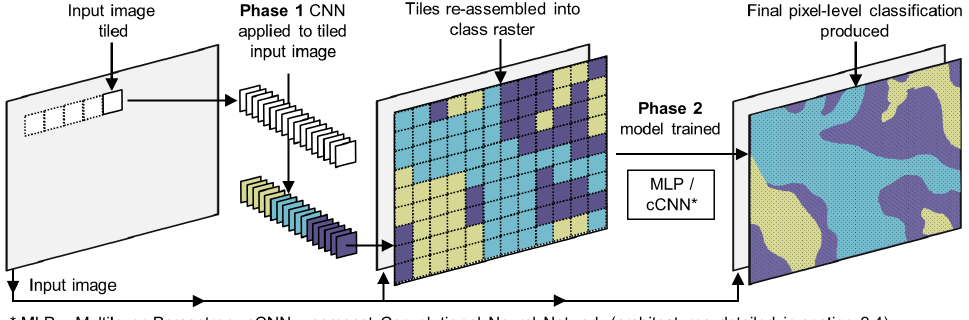
Figure 1. Conceptual diagram of the CNN-Supervised Classification workflow showing the production of a tiled class raster in phase one. Phase one predictions are then used as image-specific training labels for the phase two model which produces a final pixel-level classification.